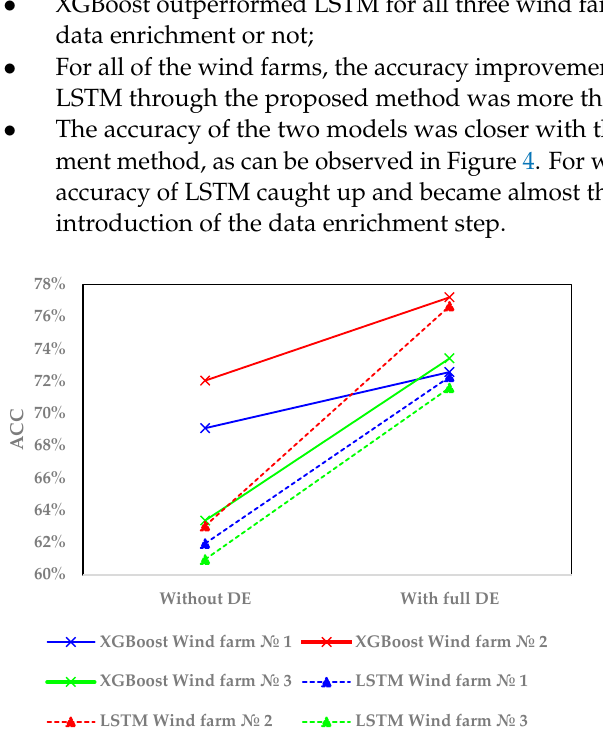
Figure 4. Accuracy 1 improvement in the proposed method on two models for three wind farms. ( 1 ACC was rounded to the first decimal place, which are with three significant digits. Compared to the original data with five significant digits and intermediate data saved to the full use of double- precision format, the calculation error of ACC was negligible).